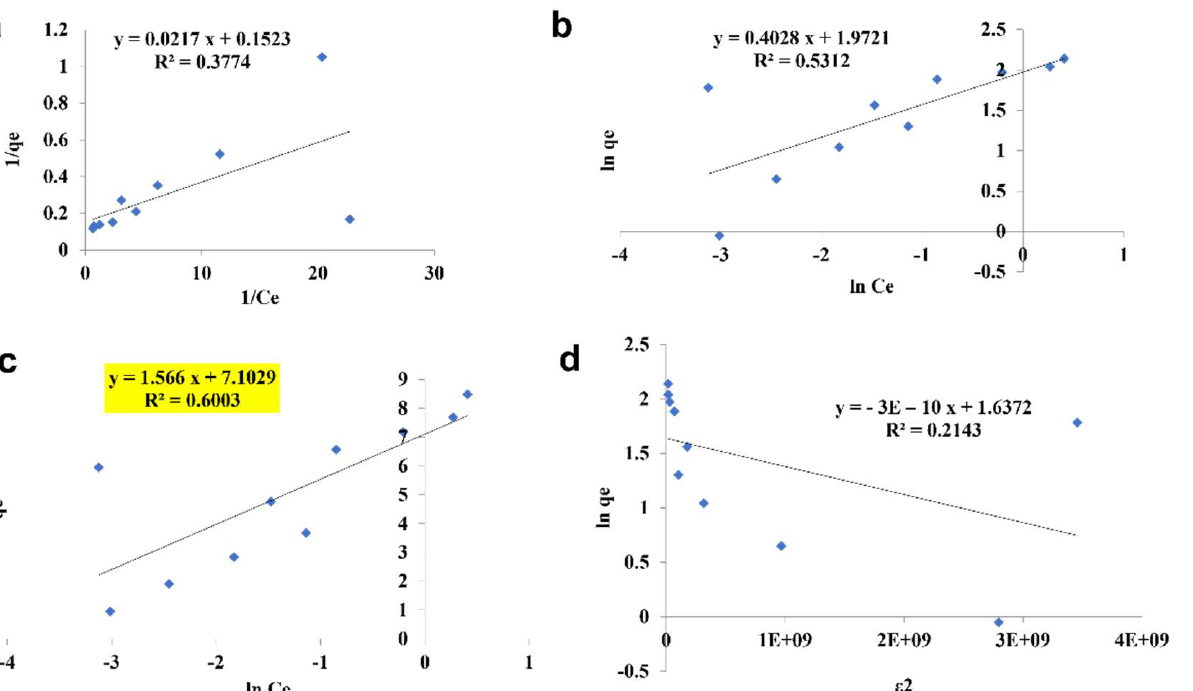
Figure 11. Isotherm study of alginate beads. ( a ) Langmuir Isotherm, ( b ) Freundlich Isotherm, ( c ) Tempkin Isotherm, ( d ) D—R Isotherm.